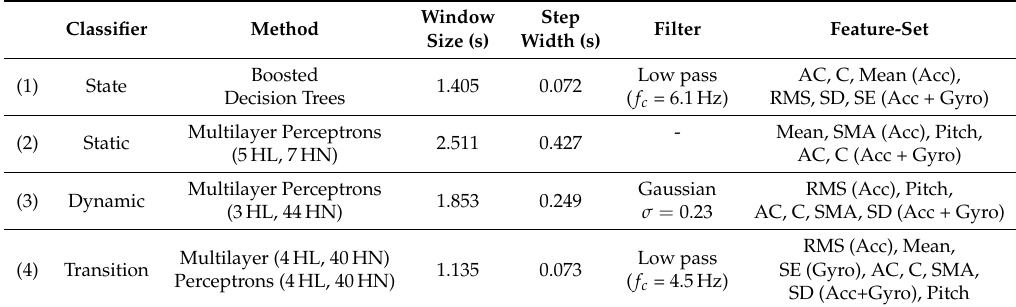
Table 3. Parameters for our classifiers: method, size and step-width of the sliding window, as well as the noise reduction filter and feature set. The abbreviations of the features are listed in the text. The used data for each feature are specified in brackets at the end of the line: Acceleration data (Acc), Gyroscope data (Gyro). The abbreviations HL and HN stand for hidden layer and hidden nodes. The cut-off frequency of the specific filters is f c . AC, Auto Correlation; C, Correlation; SMA, Signal Magnitude Area.